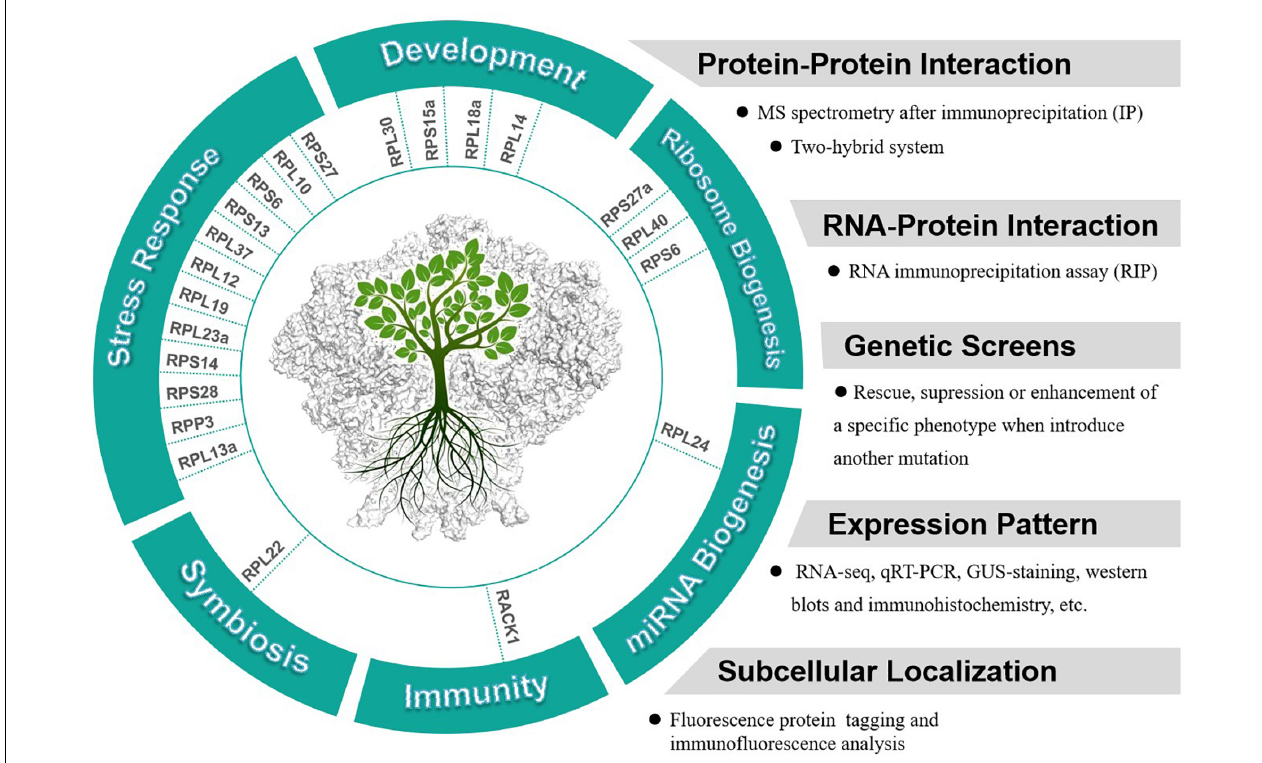
FIGURE 2 | Potential extraribosomal functions of cytosolic RPs in plants and relevant methods and appraoches to analyze extraribosomal function of RPs.